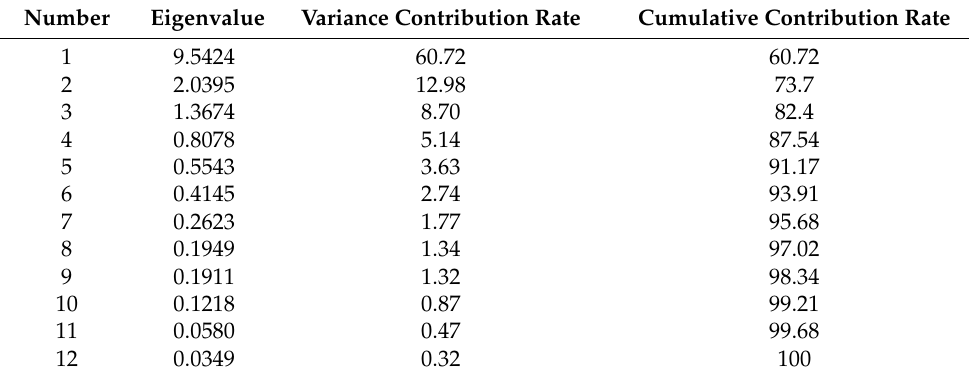
Table 2. Contribution rate of each principal component.